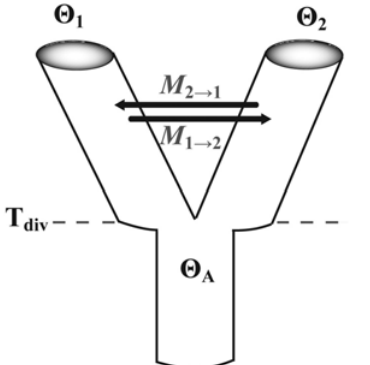
Figure 3. The six-parameter isolation-with-migration model implemented in IM and IMa [38,129]. There are three population mutation rate parameters ( Θ ), two migration parameters ( M ), and the time since population divergence (T parameter— s , the proportion of the ancestral population that founds a descendant population—can be included to allow for population size changes (not